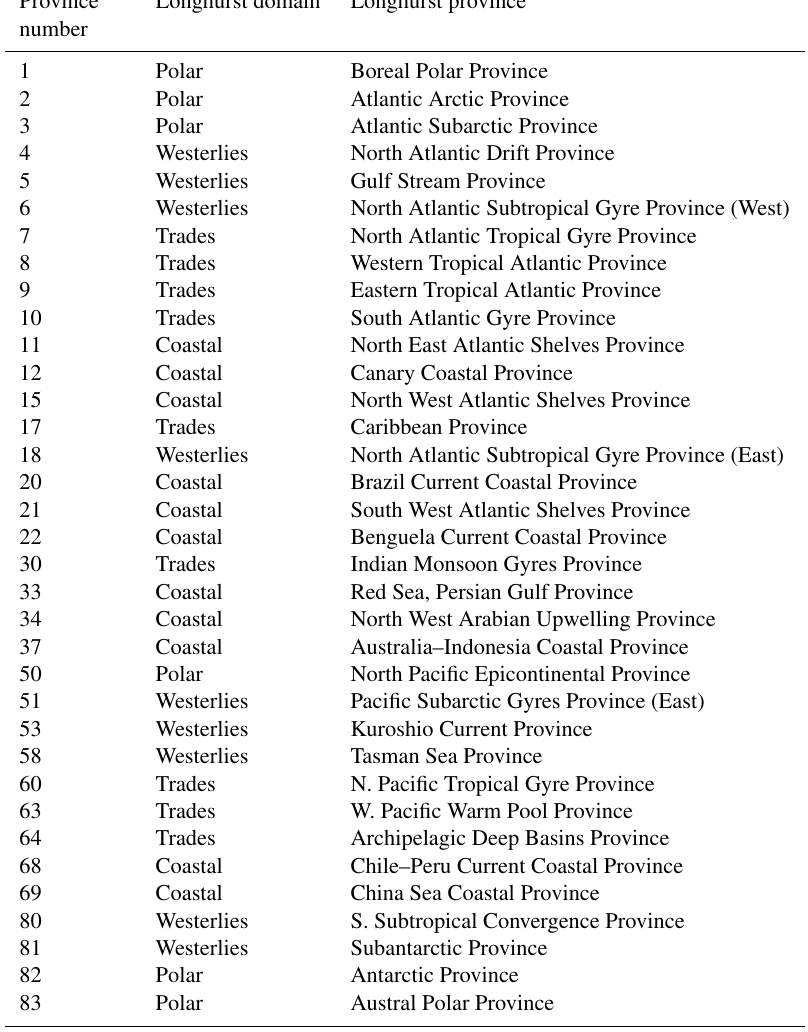
Table 1. Numbers corresponding to biogeochemical province and domain as described by Longhurst (2007) included in the MAPPS